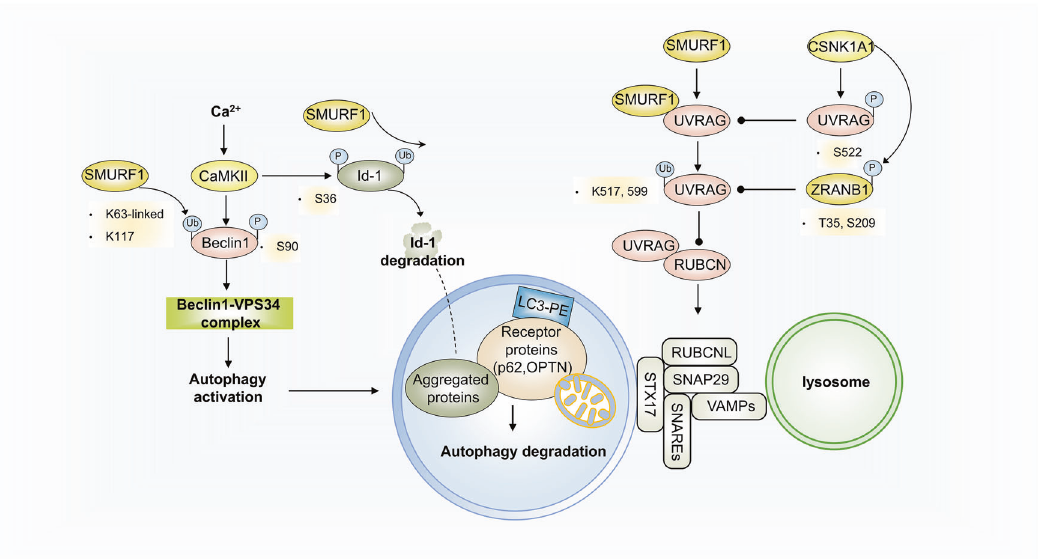
Fig. 8 Crosstalk between phosphorylation and ubiquitination in autophagy regulation. SMURF1 forms a complex with UVRAG by binding to the PPxf motif and catalyzes K29- and K33-linked polyubiquitination of UVRAG at the K517 and K599 residues. Ubiquitinated UVRAG blocks RUBCN ’ s approach to the UVRAG-containing PIK3C3 complex, inhibiting the negative effect of RUBCN and promoting autophagosome maturation. CSNK1A1-mediated UVRAG phosphorylation at S522 disrupts the binding of SMURF1 to UVRAG and reverses UVRAG ubiquitination-mediated autophagosome maturation. CaMKII phosphorylates Beclin1 at S90 and subsequently increases TRAF6-catalyzed Beclin1 K63-ubiquitination, collectively contributing to autophagy induction for K63-linked ubiquitylated Id-1/2